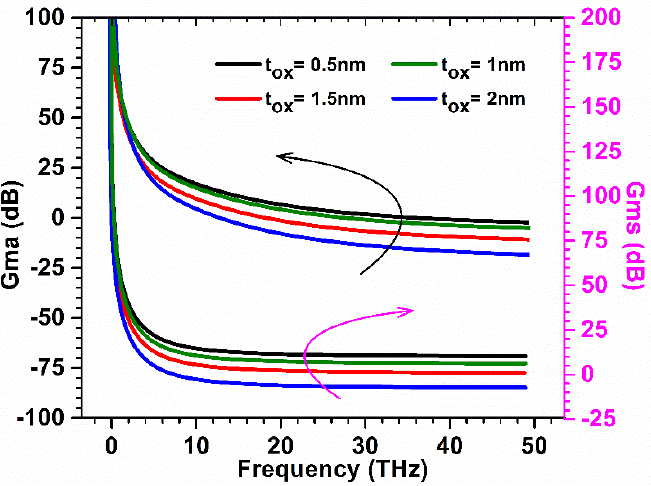
Figure 15. Gma and Gms at various oxide thicknesses of GaN-SOI-FinFET.